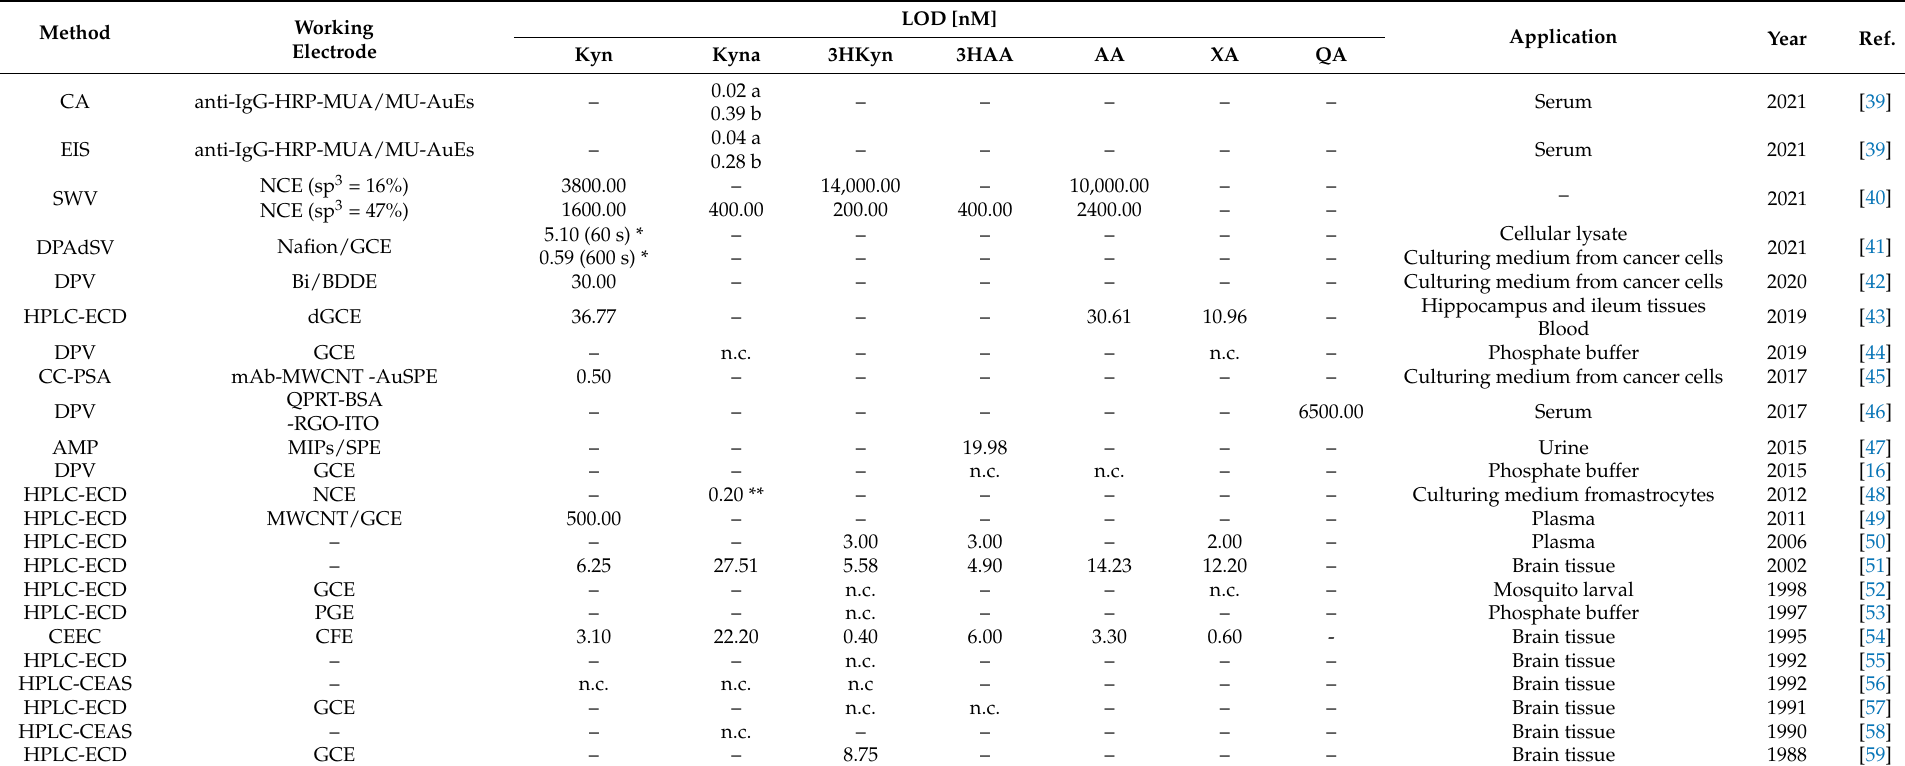
Table 1. Progress and achievements in electrochemical determination of kynurenine pathway